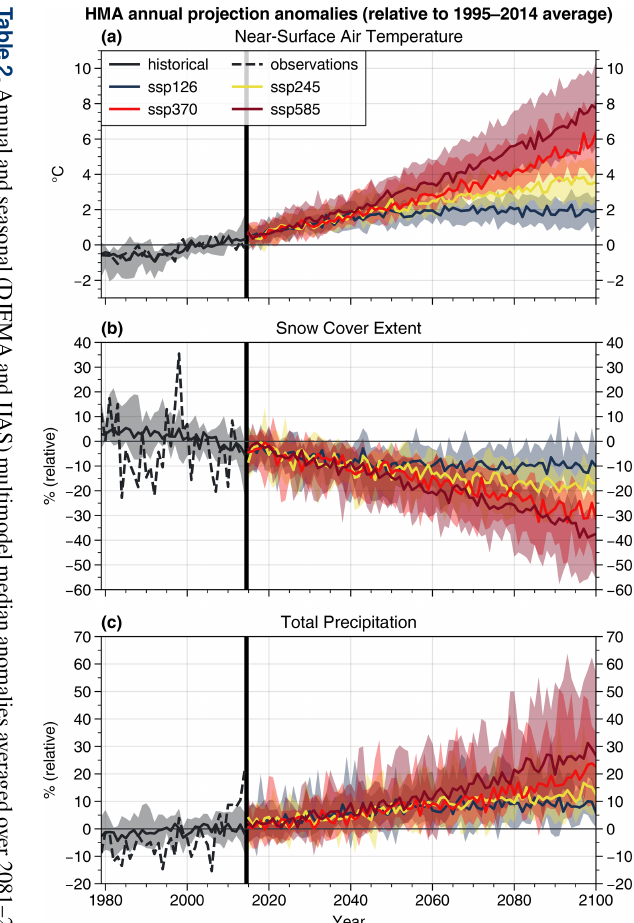
Figure 9. Annual yearly anomalies (with respect to the mean com- puted over 1995–2014) simulated in HMA over 1979–2014 (black curves) and over 2015–2100 under four scenarios: SSP1-2.6 (dark blue), SSP2-4.5 (yellow), SSP3-7.0 (red) and SSP5-8.5 (dark red) for temperature (a) , snow cover (b) and precipitation (c) . Medians are computed with the first member for the 10 models for which the future projections are available (Table 1). The thick vertical black line delimits the historical and future periods. CRU, NOAA CDR and APHRODITE observations dataset are shown for the histori- cal period in dashed lines, respectively, for temperature, snow cover and precipitation. Shadings highlight the 90% confidence interval, corresponding to the 0.05 and 0.95